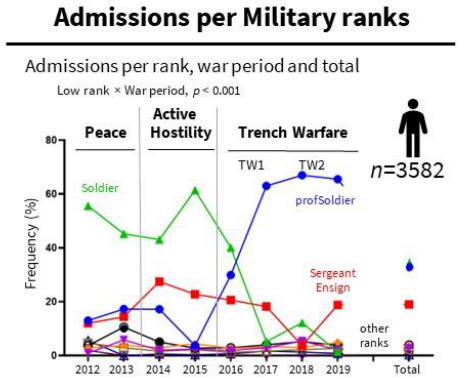
Figure 2. Admissions per Military ranks. Admissions per rank, war period and total ANXd: Anxiety, dissociative, stress-related, somatoform and other nonpsychotic mental disorders; PSUd; Mental and behavioral disorders due to psychoactive substance use. Statistics (see depicted in the inset): Frequencies (%), Chi-square.